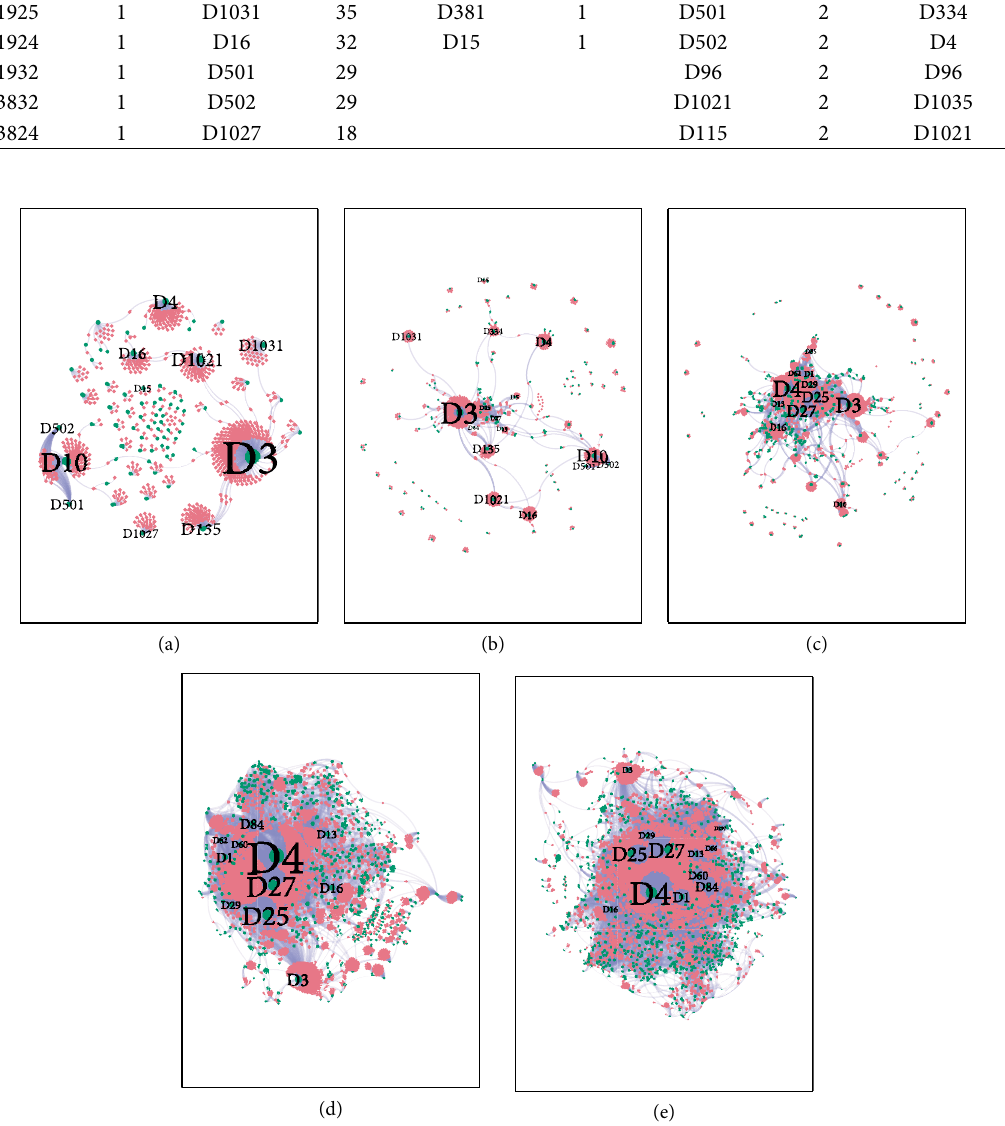
Figure 4: The sub-networks of drafting in different stages. (a) 1997, (b) 2002, (c) 2007, (d) 2012, (e)